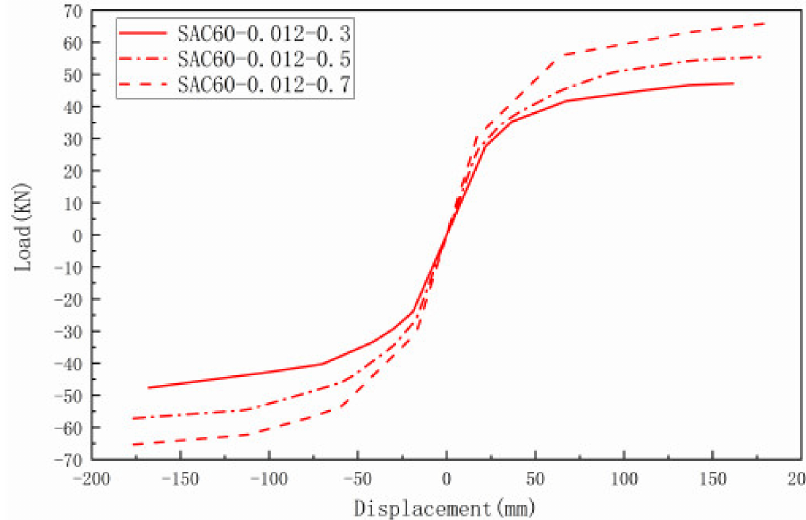
Figure 18. Skeleton curves of